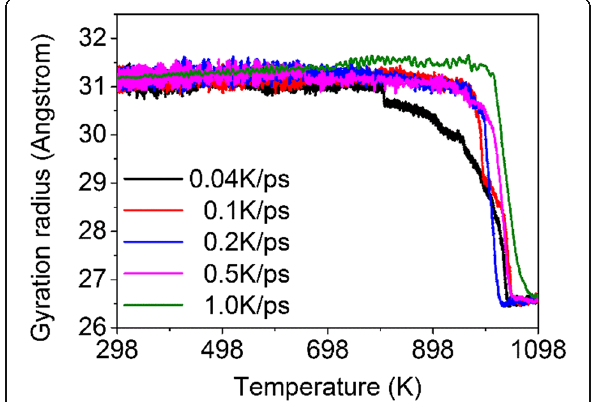
Fig. 6 Gyration radius as a function of temperature during the heating process with different heating rates